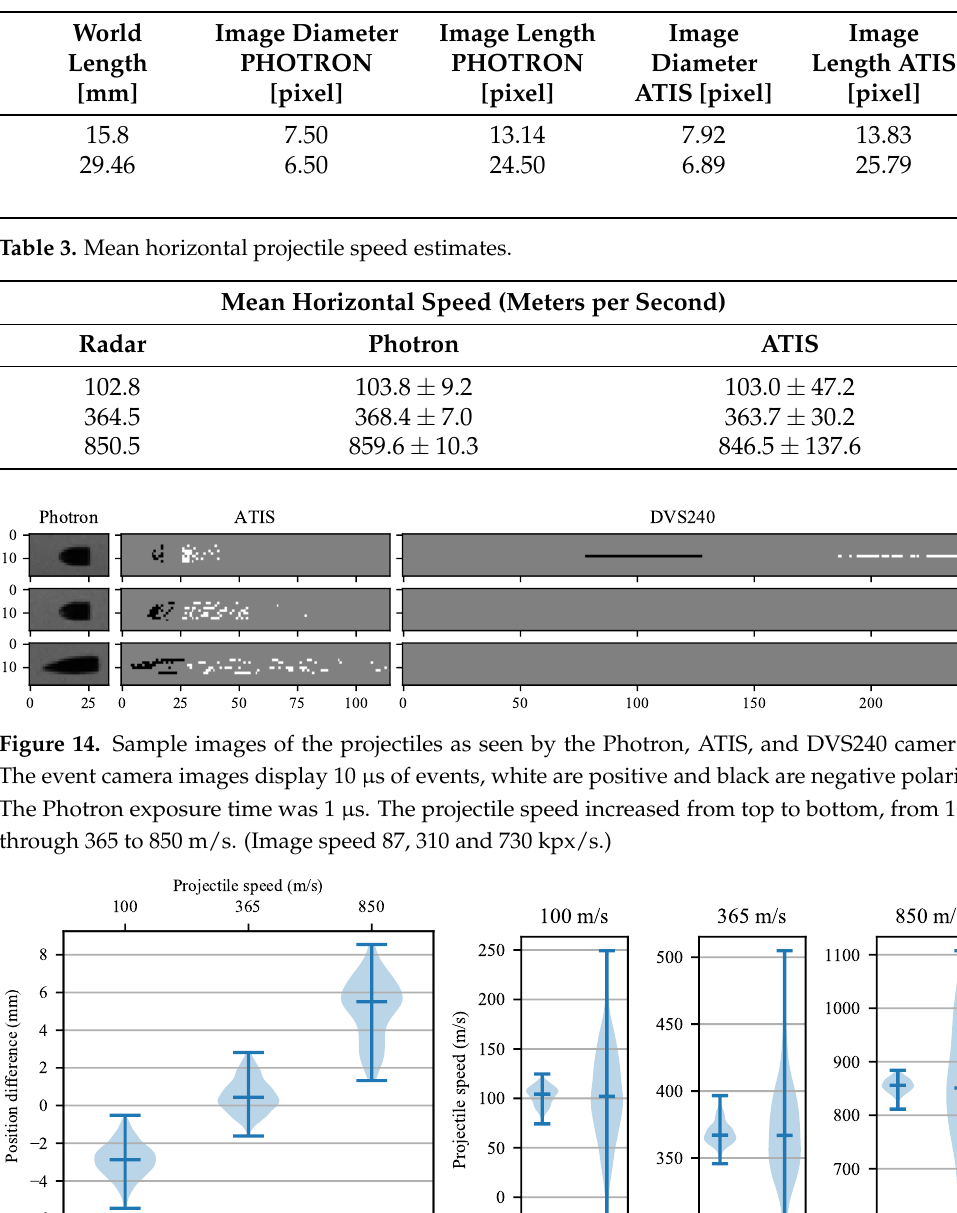
87 310 730 Image speed Figure 15. ( a ) Distributions of the differences between the ATIS and Photron estimates of horizontal projectile position. Data were measured for three projectile speeds along a trajectory segment 440 mm long. A positive difference means that the ATIS estimate lags in time behind the Photron estimate. The horizontal lines of each violin show the maximum, median, and minimum position differences; ( b ) distributions of the ATIS and Photron projectile speed estimates along a trajectory segment 440 mm